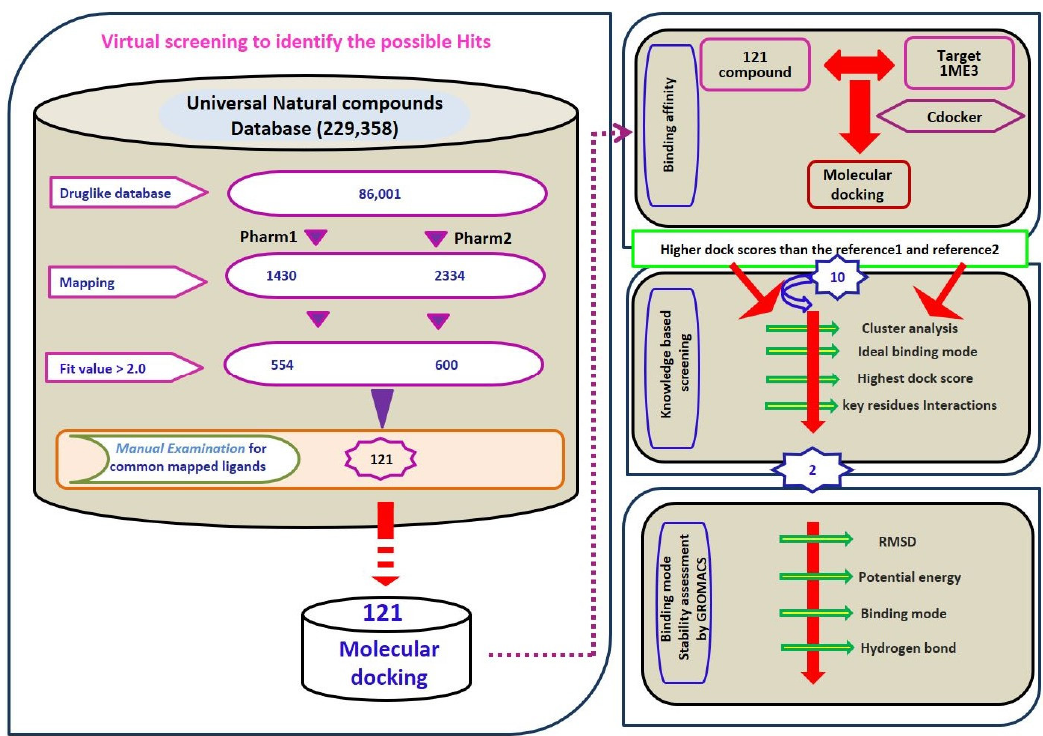
Figure 5. Overview of the screening methodology adapted.